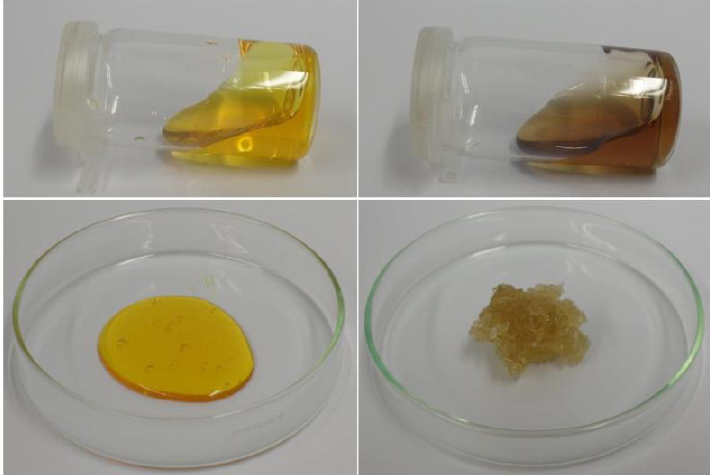
Figure 3. Digital photographs of the polyester resins obtained in the presence of Zn(OAc) 2 ( left ) and MSA ( right ) after 6 h ( upper row ), and at the end of the reaction ( lower row ).